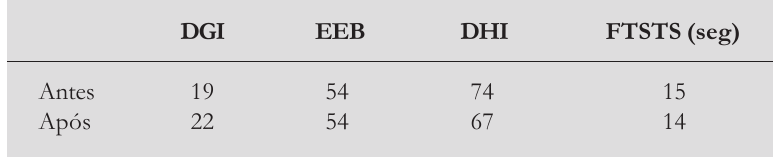
Tabela 2 - Pontuação das escalas mensuradas antes e após o tratamento com o